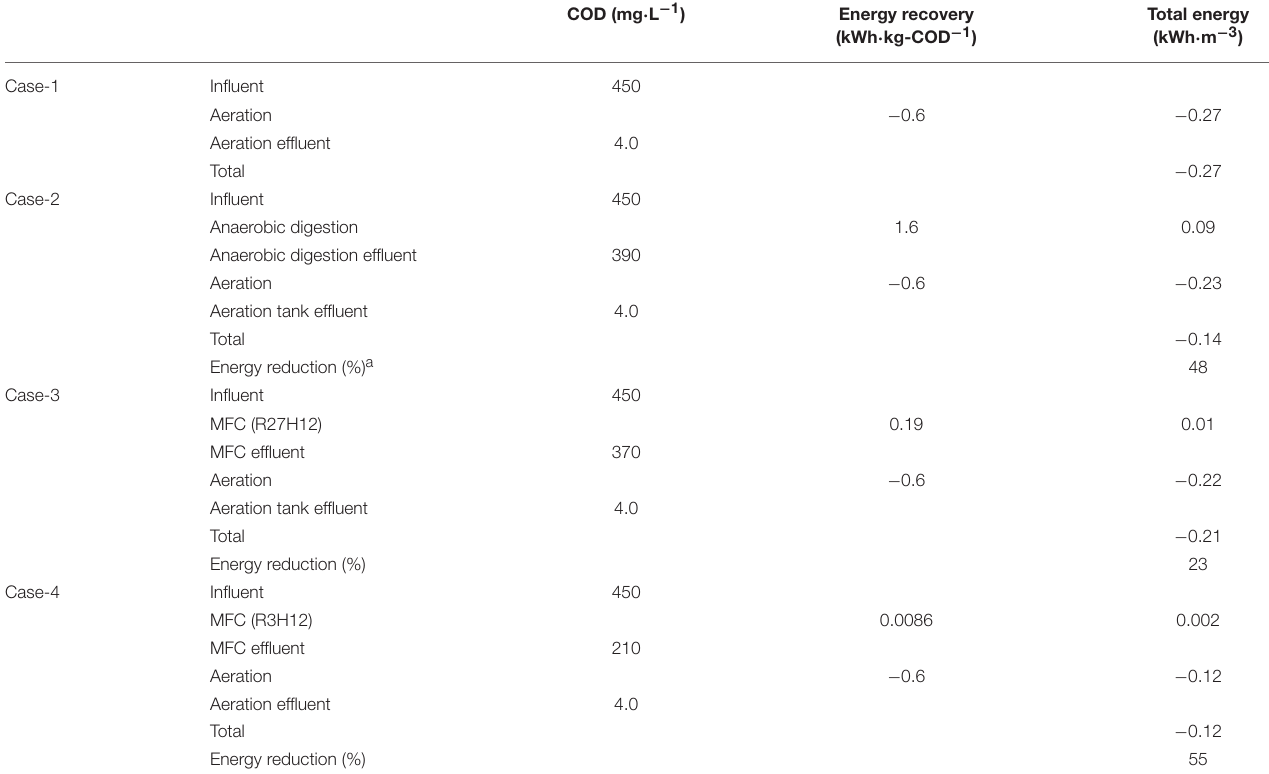
TABLE 2 | Energy reduction via the installation of the